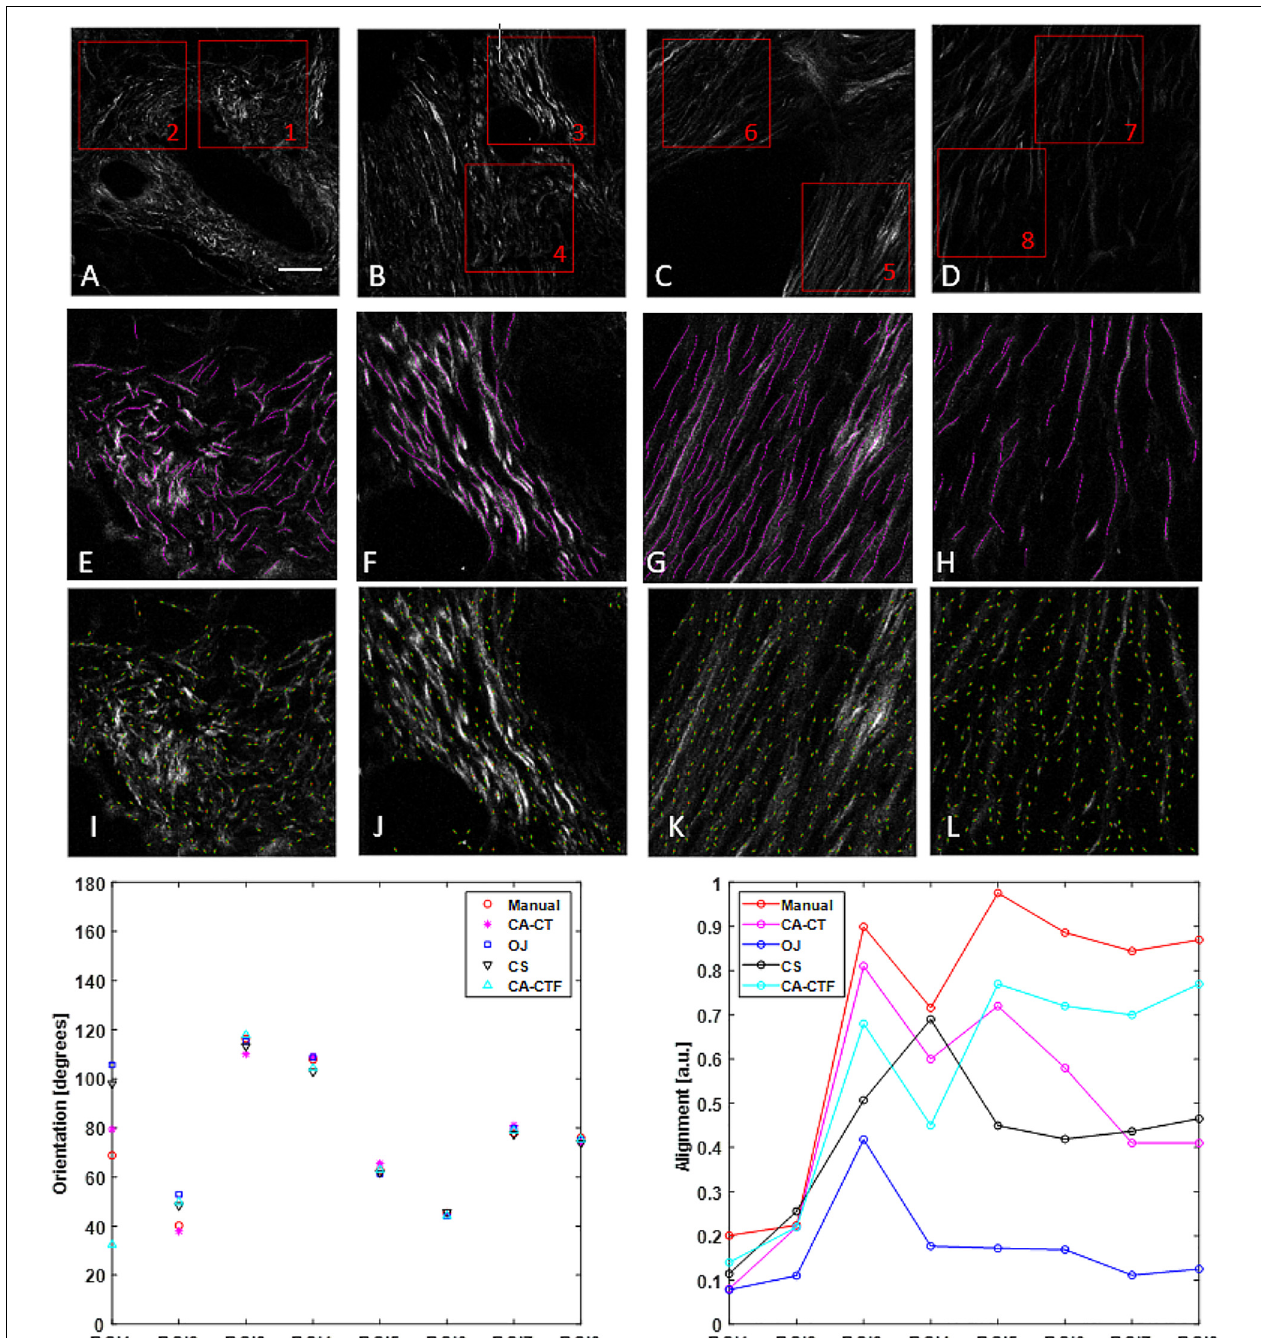
FIGURE 2 | Collagen orientation calculation on SHG images of human pancreatic tissue with CurveAlign (CA) and its comparison with manual measurement and two other open-source tools including structure tenor based OrientationJ (OJ) and Fourier transform-based CytoSpectre (CS). (A–D) show the original SHG images and the location of eight ROIs. (E–H) show the manually labeled fibers (in magenta) overlaid on the original images of ROIs 1, 3, 5, and 7, respectively. (I–L) show curvelets (in green color) represented orientations on the original images of ROIs 1, 3, 5 and 7, respectively. The bottom row shows the comparison in orientation (left) and alignment (right). For the ROIs with relative larger alignment coefficient including ROIs 3–8, all the methods yield similar orientation. For ROIs 1–2 with relative small alignment, the discrepancy becomes bigger, with the CurveAlign Curvelets analysis mode (CA-CT) being closest to the manual measurement. All the methods share some similar trends in alignment measurement, with the CurveAlign fiber segments analysis mode (CA-CTF) being closest to the manual measurement. The differences are mainly due to the different fiber orientation detection algorithm and fiber alignment definition. Images (A–D) are shown at the same scale while images (E–L) are shown at the same scale. Scale bar equals 50